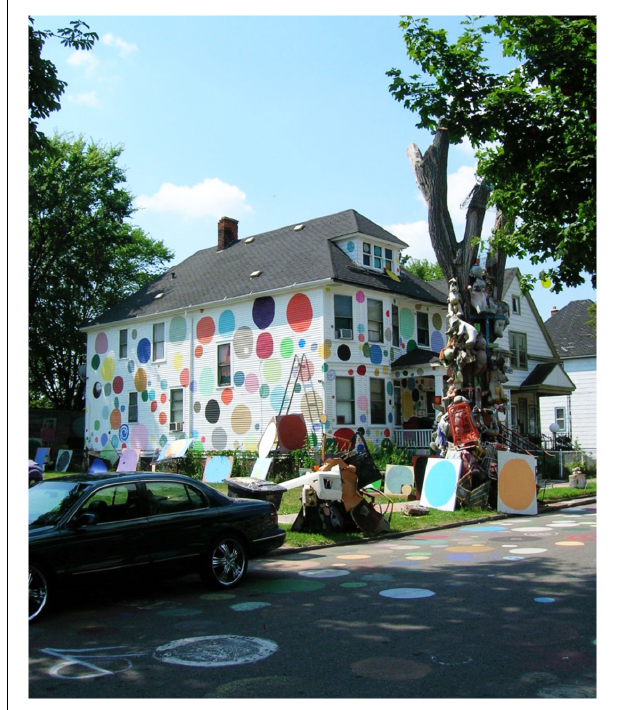
FIGURE 3 | A view of art